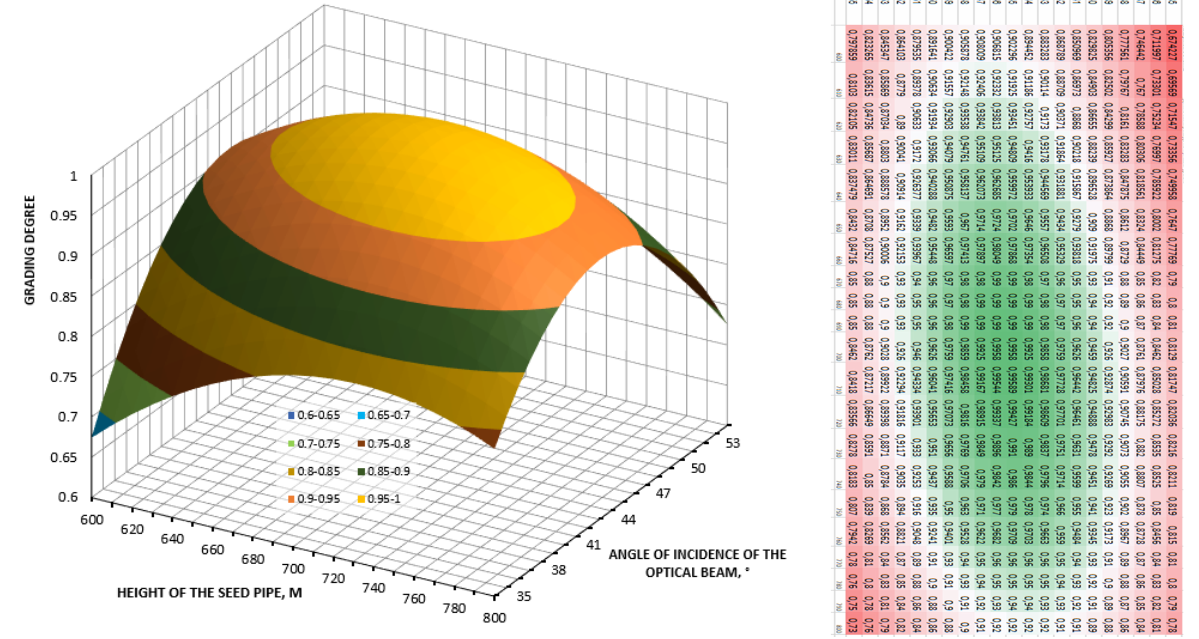
Figure 3. The response surface ( left ) and Excel–nomogram ( right ) determine the optimum when implementing a composite full–factor experiment when fixing the height of the seed pipe in the center of the plan at the level of 0.2 m.